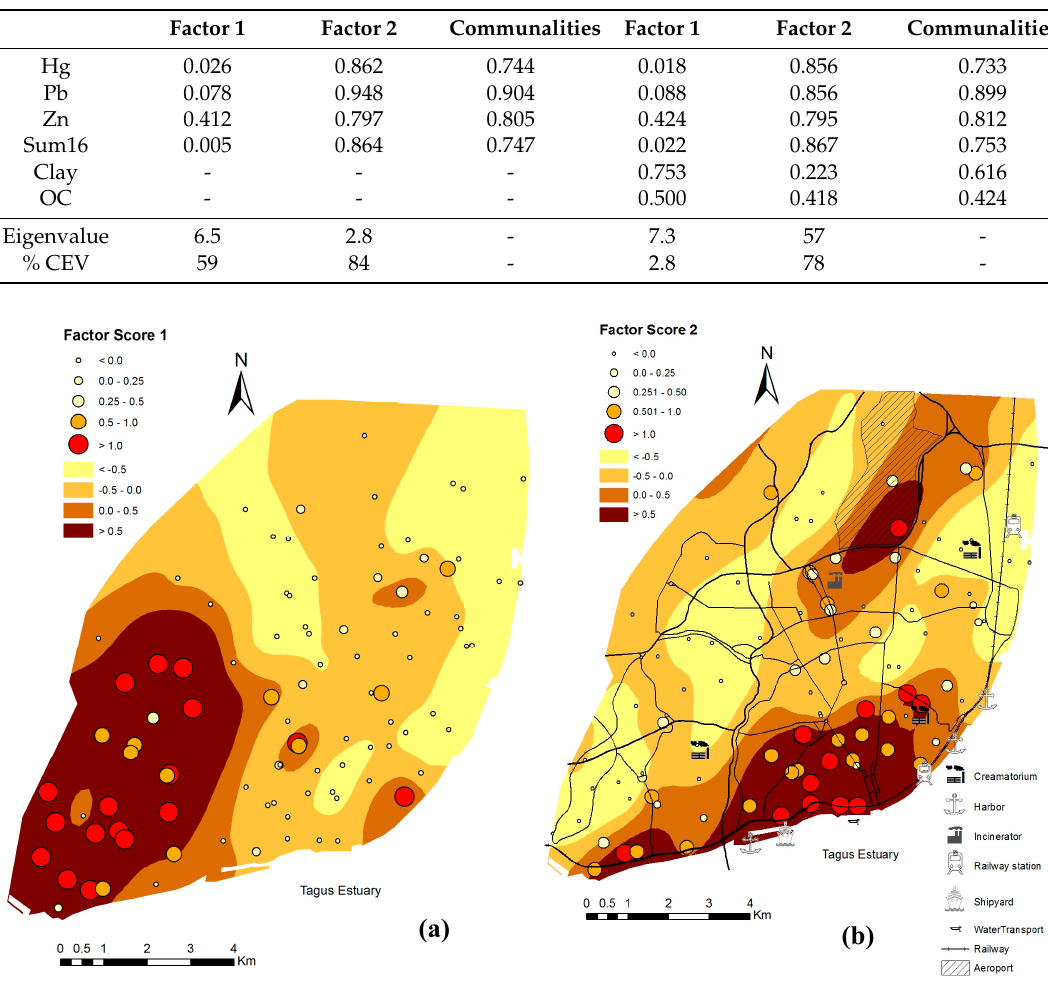
Figure 2. Contour maps (interpolated by ordinary kriging) for the first ( a ) and second ( b ) factor scores obtained in the factor analysis.